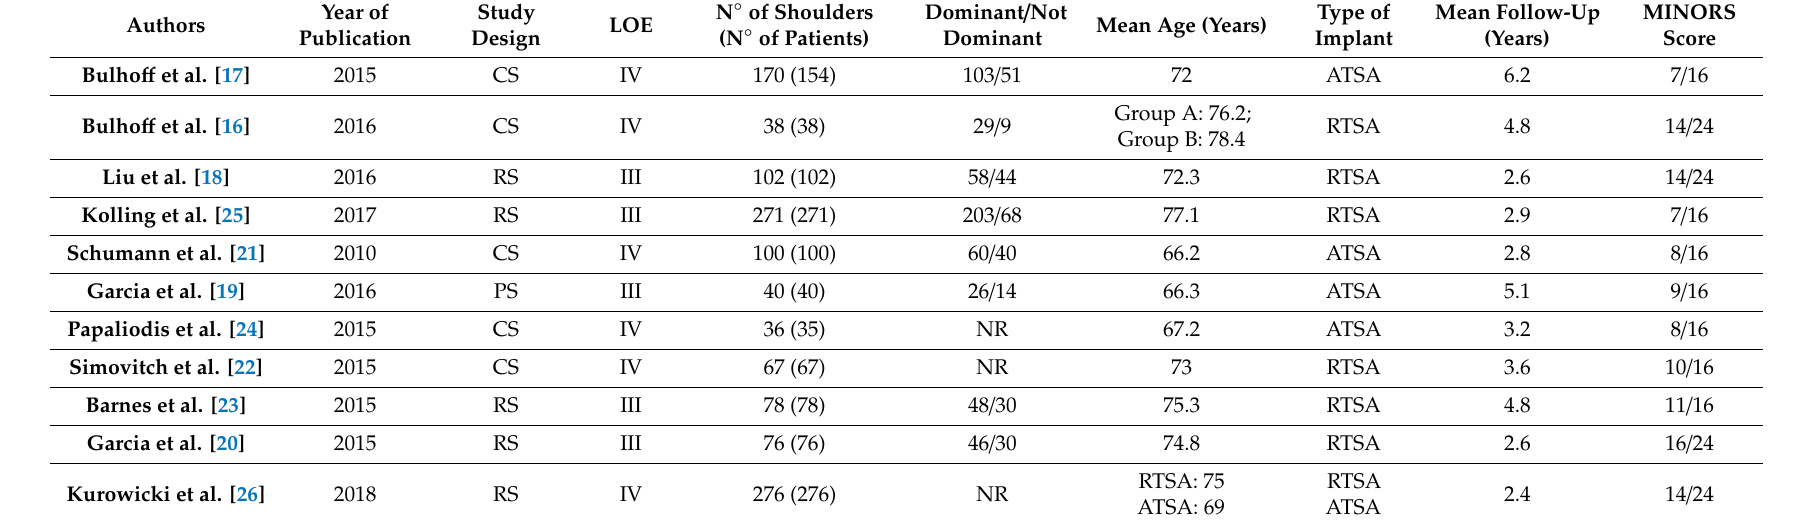
Table 1. Study characteristics, demographic details and Methodological Index for Non-randomized Studies (MINORS)